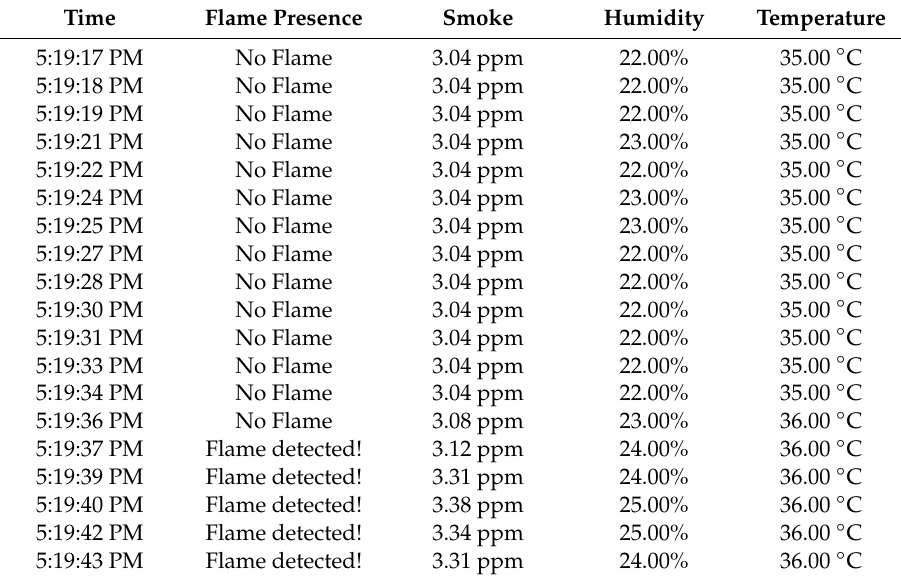
Table 1. A sample of experimentally measured data in real-time.